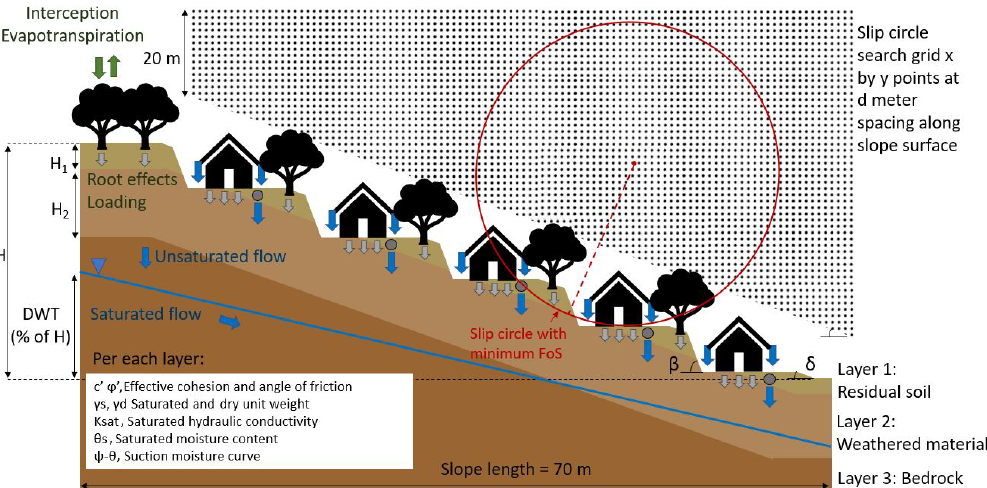
Figure 4. Example of slope generated by stochastically sampling from the ranges of input factors specified in Table 1. H is the slope height resulting from the fixed slope length and varying slope angles. The dimensions of the slip circle search grid are fixed, with an initial height of 20m and width equal to the slope length. The grid extends downslope parallel to the slope as